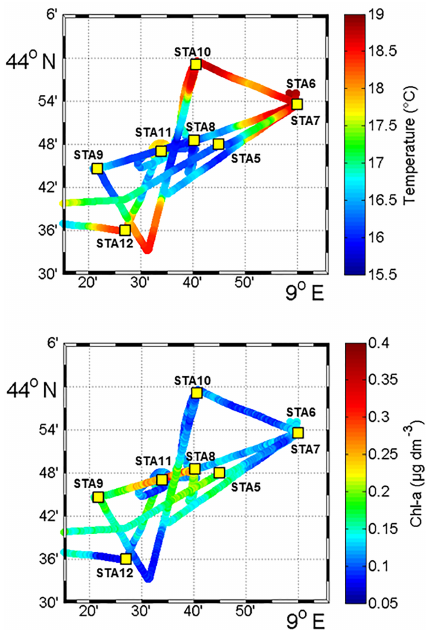
Figure 2. Sea surface temperature (SST, in ◦ C) and Chl a concen- trations (µgdm − 3 ) obtained from fluorescence continuous surface measurements from 3 November to 6 November during the OSC- AHR campaign and fixed station locations (STA5 to STA12). This study area corresponds to the black box represented in Fig.